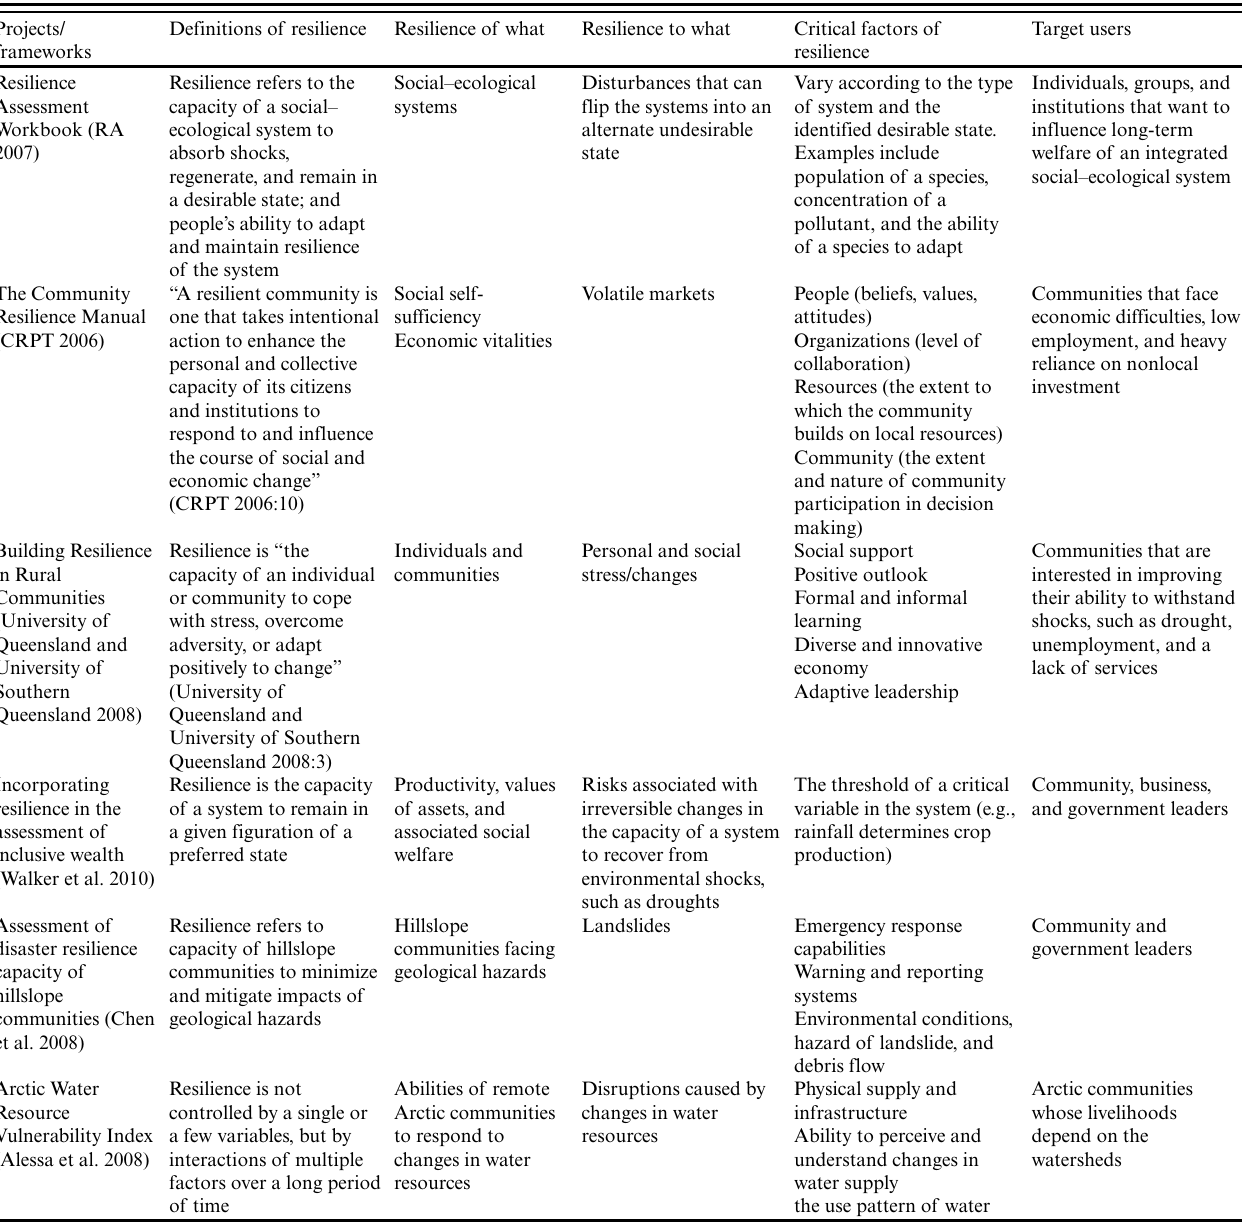
Table 1. An overview of the resilience assessment framework and other frameworks Projects/